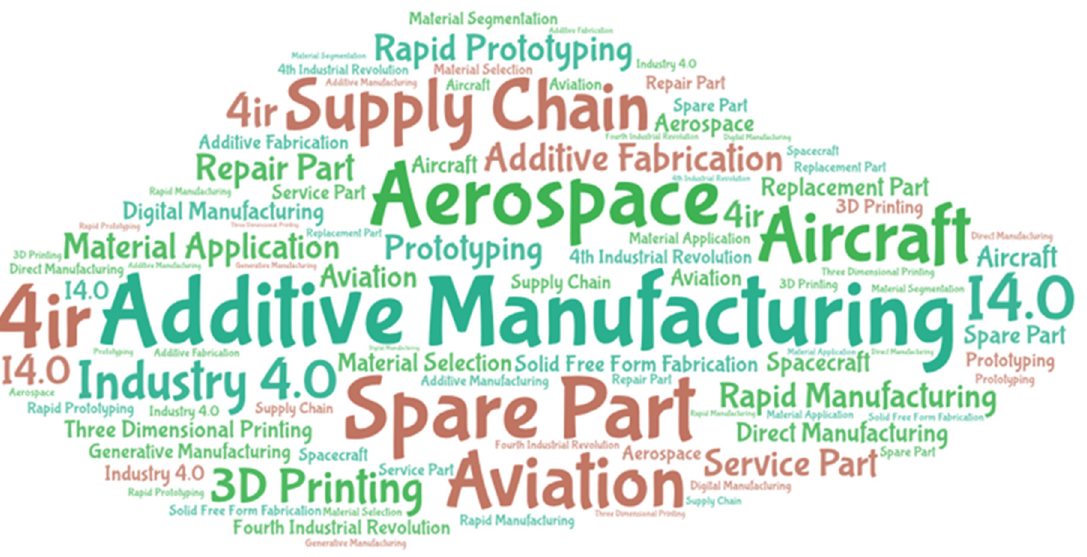
Figure 3. Keywords for the literature search.